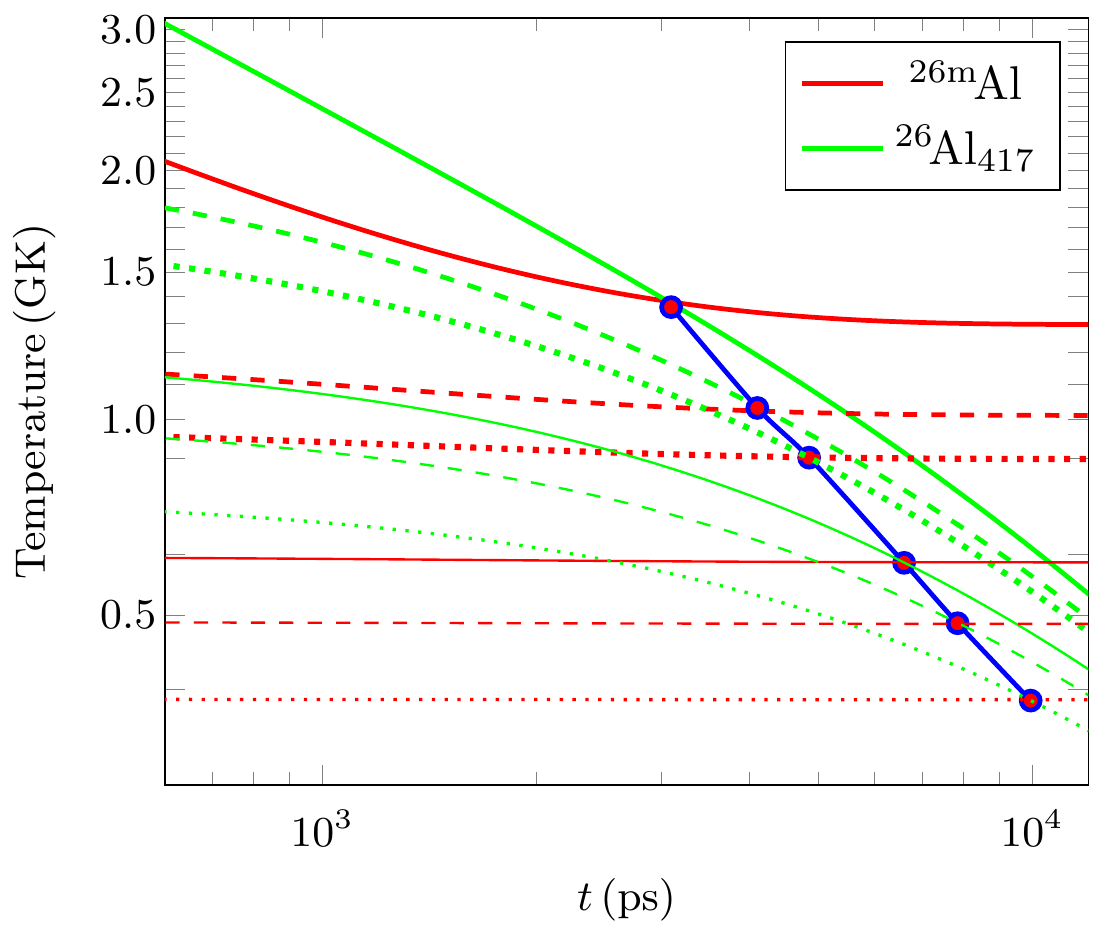
Figure 3. Calculated T equivalents for Y 228 / Y g.s. (red lines) and Y 417 / Y g.s. (green) from yield distributions according to Maxwell-Boltzmann distribution, for consecutive pulse numbers 1 (solid thick), 2 (dashed thick), 3 (dotted thick), 5 (solid thin), 25 (dashed thin) and 100 (dotted thin). The protons are considered to irradiate the same volume in the secondary target. The times t equi for each pulse at which the two yield ratios converge to resemble one temperature value T , are indicated by the blue & red circles which are connected with a blue line to guide the eye.